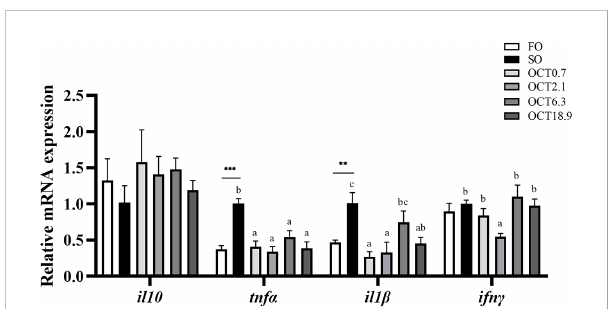
FIGURE 6 Effects of supplemental octanoate on the expression of in fl ammation-related genes in the liver of large yellow croaker. Values were means (n = 3) with their standard errors represented by vertical bars. ∗∗ represent a signi fi cant difference of P < 0.01 between the SO group and the FO group. ∗∗∗ represent a signi fi cant difference of P < 0.001 between the SO group and the FO group. Different letters show signi fi cant difference ( P < 0.05) among OCT treatment groups. Linear trend and Quadratic trend were analyzed by orthogonal polynomial contrasts. il10 , interleukin-10; tnf a , tumor necrosis factor- a ; il1 b , interleukin-1 b ; ifn g , interferon- g . Polynomial analysis: il10 : P Linear = 0.638, P Quadratic = 0.031; tnf a : P Linear = 0.000, P Quadratic = 0.000; il1 b : P Linear = 0.019, P Quadratic = 0.001; ifn g : P Linear = 0.280, P Quadratic =